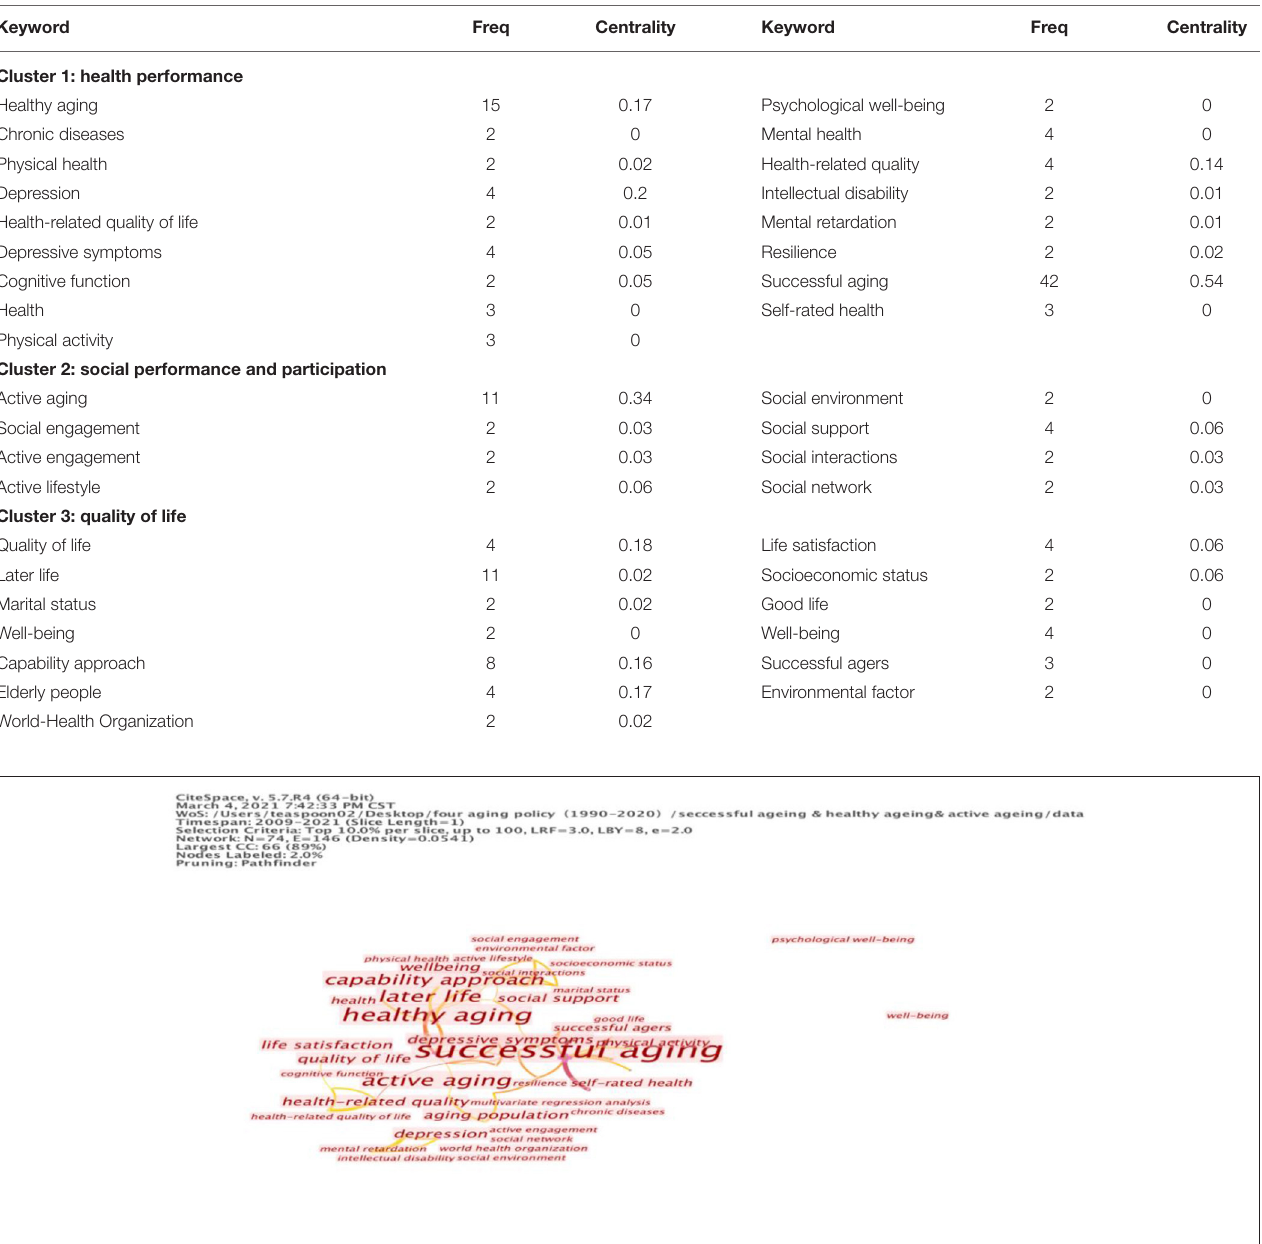
TABLE 5 | Successful aging AND healthy aging AND active aging.